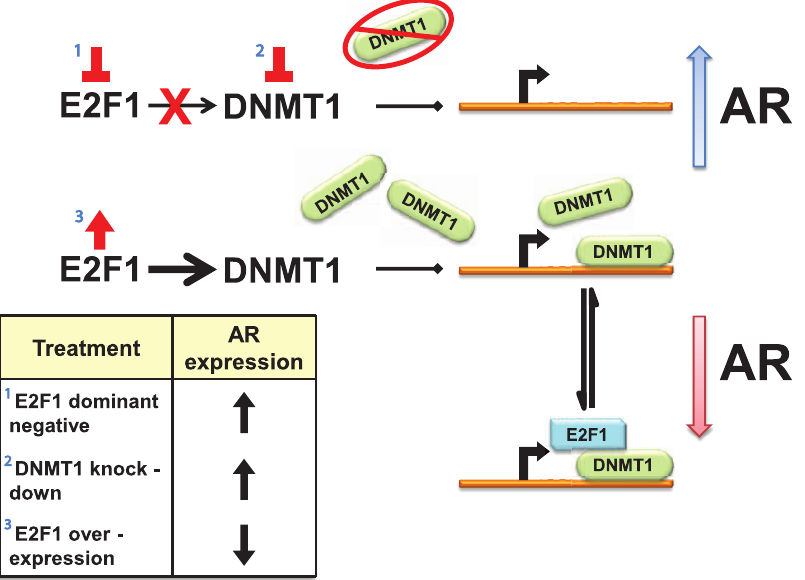
Figure 6. Schematic representation of AR repression through the E2F1/DNMT1 axis. The use of either a dominant negative E2F1 construct or a shRNA to knock down DNMT1 both result in the downregulation of DNMT1 and subsequent rescue of AR expression. E2F1 overexpression experiments suggest that elevated E2F1 levels increase DNMT1 protein expression that associates directly with the AR promoter or possibly in complex with E2F1 to repress AR.